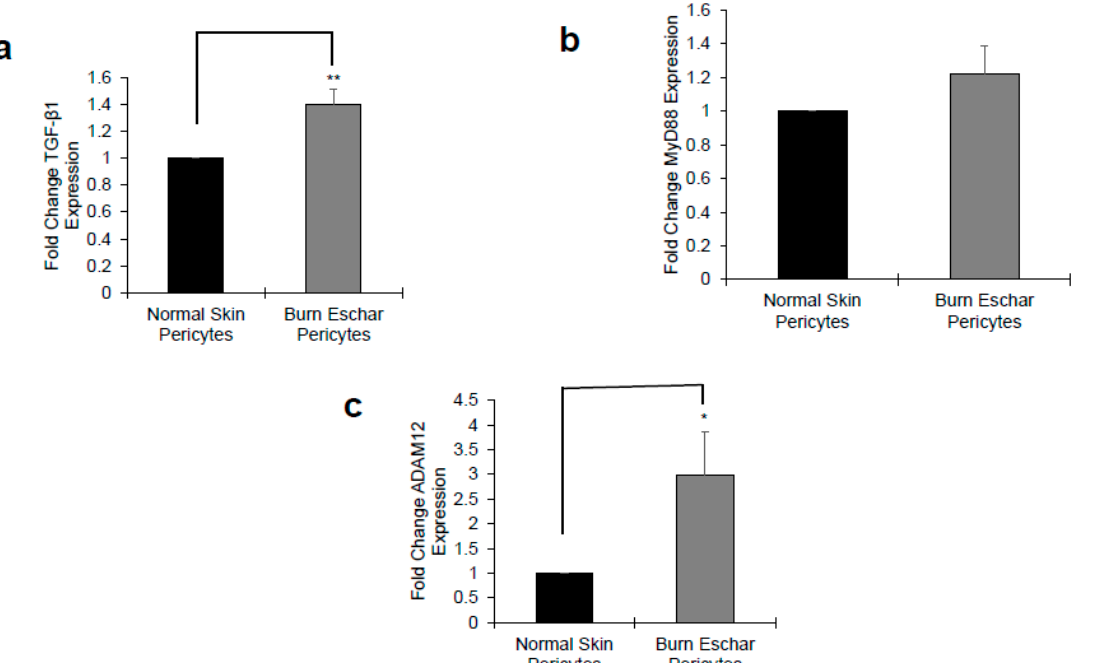
Figure 4. Burn eschar pericytes express high levels of pro-fibrotic genes. Normal and burn eschar pericytes were analyzed for transcription of ( a ) transforming growth factor (TGF)- β 1, ( b ) myeloid differentiation factor 88 (MyD88), and ( c ) A disintegrin and metalloprotease 12 (ADAM12) using real time RT-PCR. Burn eschar pericytes display significantly higher expression of TGF- β 1 and ADAM12 than normal pericytes. Statistical analysis was performed using ANOVA with p < 0.05 considered statistically significant. Values are means ± SEM of three independent studies using three different cultures for both the cell types performed in triplicate. * p < 0.05; ** p < 0.01.